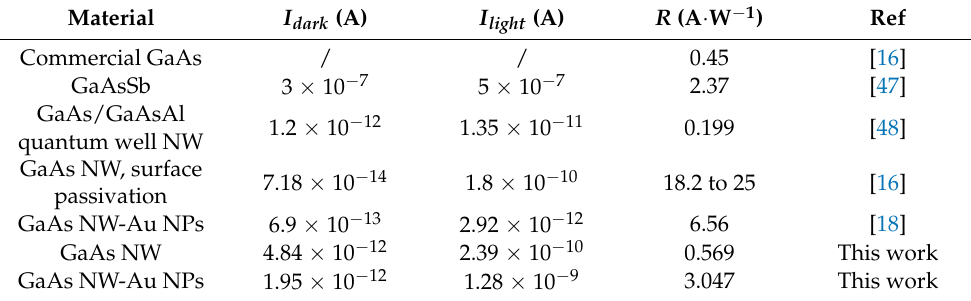
Table 1. Performance comparison of GaAs-based NW photodetectors.